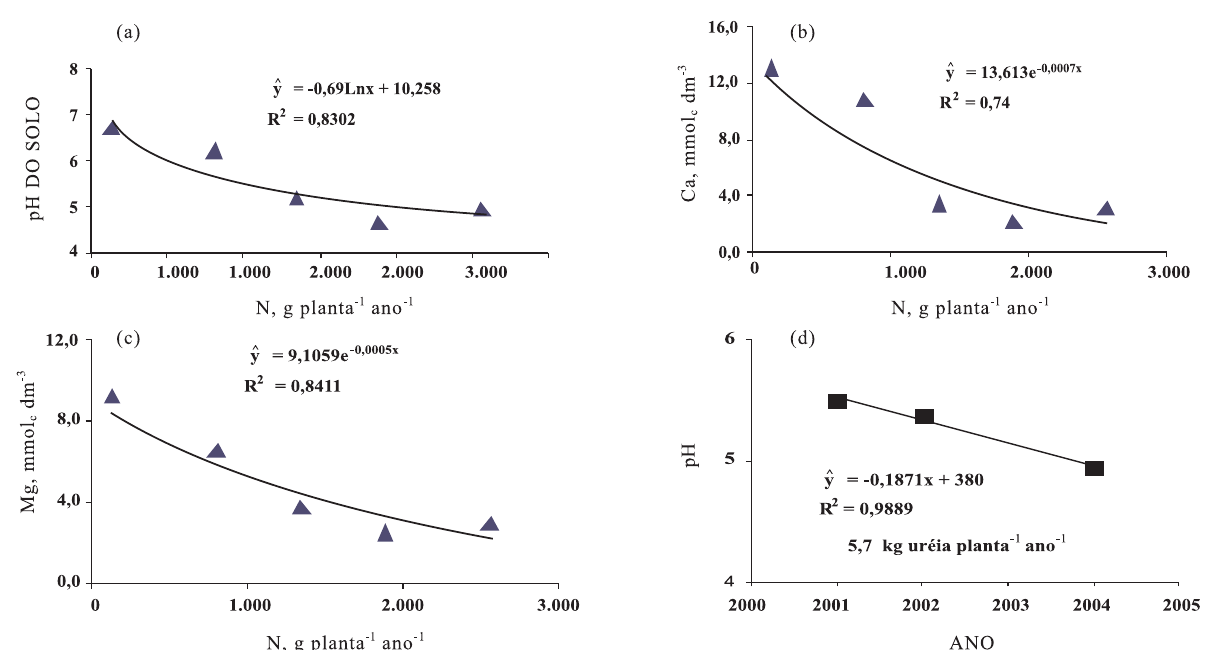
Figura 1. Influência de doses de N-uréia no pH (a), nos teores de cálcio (b) e de magnésio trocáveis (c) e no decréscimo do pH em função do tempo (d) na profundidade 0–20 cm. Quadro 1. Condutividade elétrica no extrato saturado de amostras coletadas em quatro profundidades do solo, na área de influência do